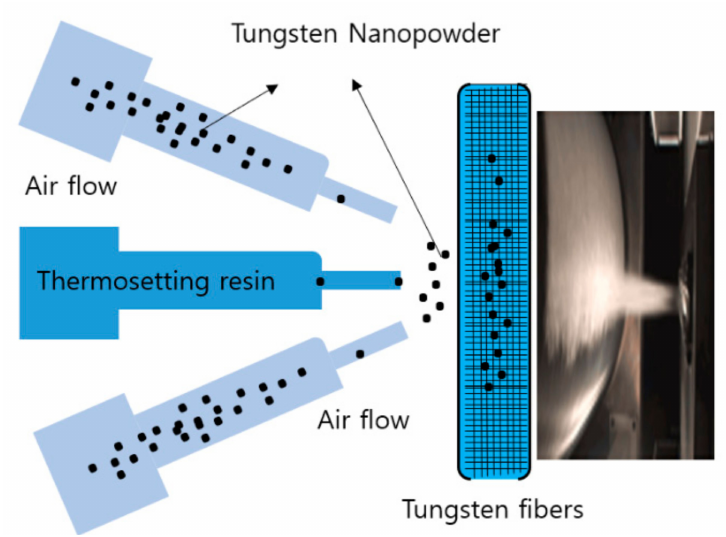
Figure 4. Tungsten nanopowder dispersion